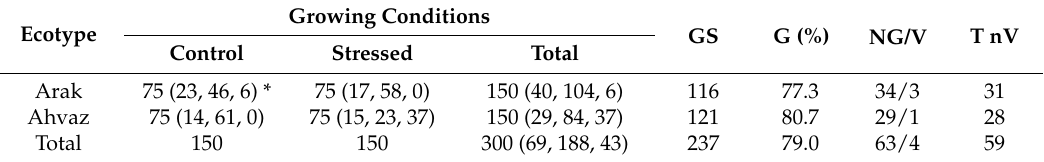
Table 1. Number of seeds grown under controlled and stressed conditions. The values in parenthesis indicate the number of light, medium and heavy castor seeds, respectively. Abbreviations are the total number of germinated seeds (GS), germination percentages (G%), non-germinated and viable seeds (NG/V) and total non-viable seeds (T nV).